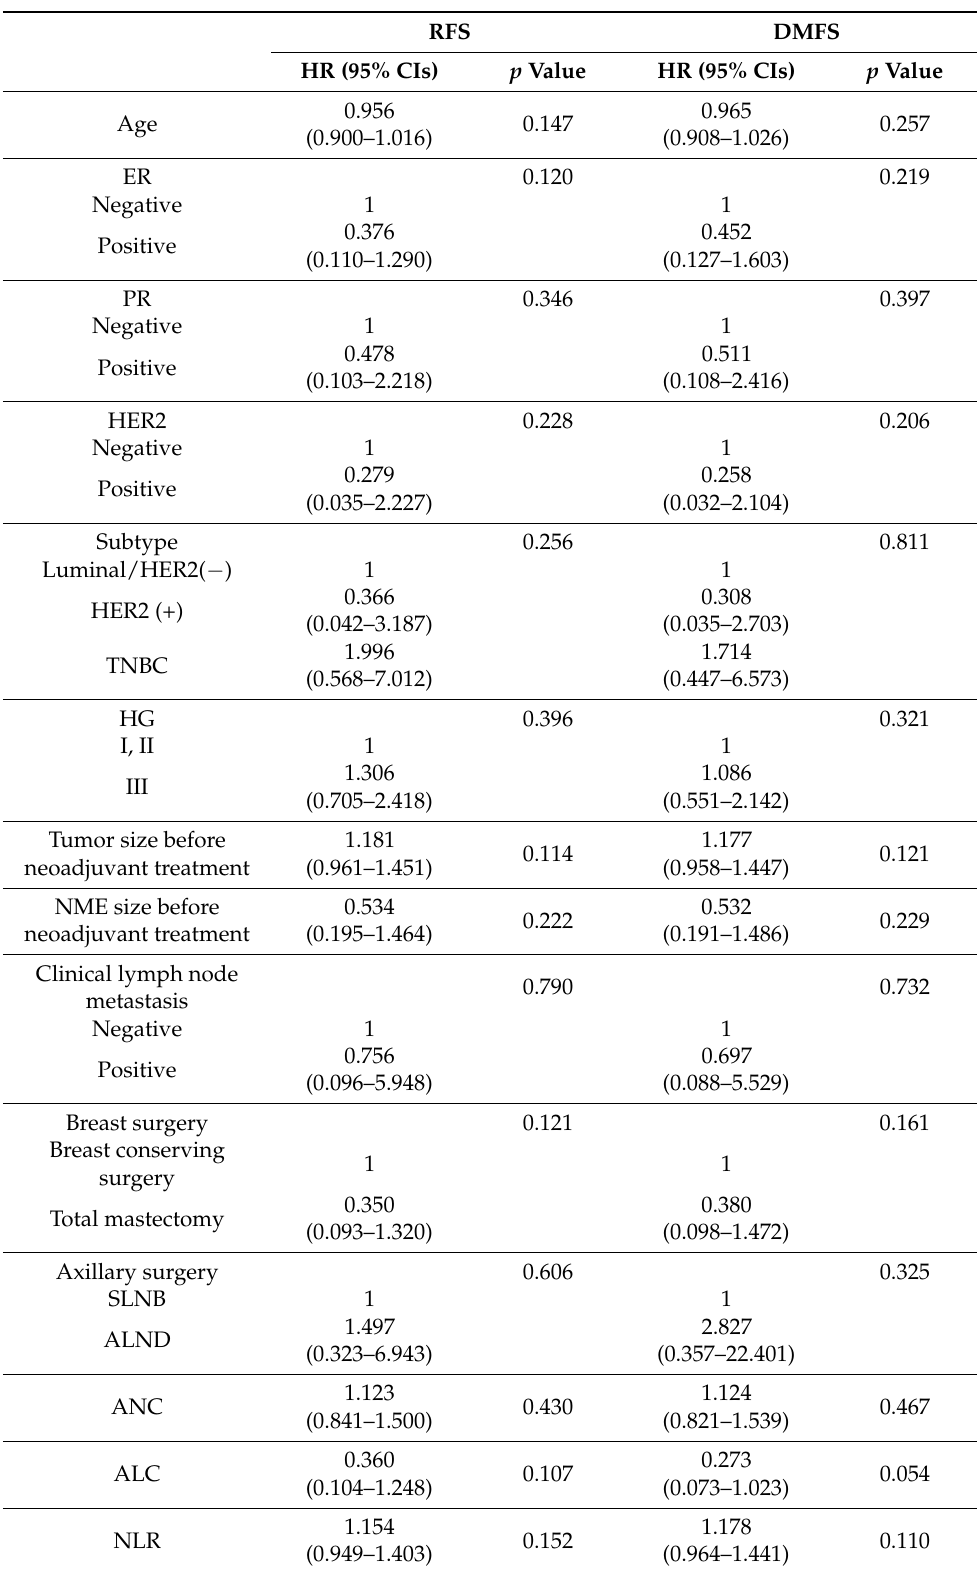
Table 2. Univariate analysis for recurrence-free survival (RFS) and distant metastasis-free survival